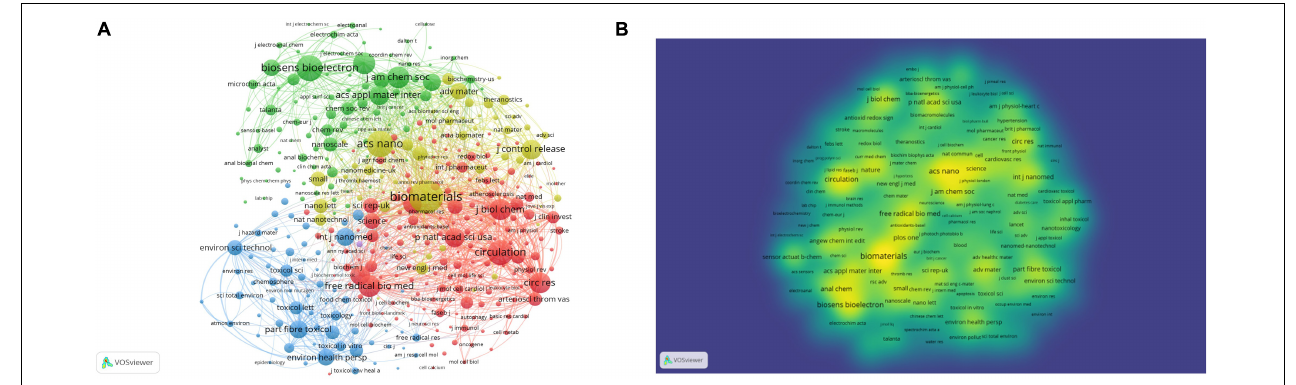
FIGURE 7 | Co-citation analysis of citated sources. Node size suggests the citation amount. Settings in VOSviewer Analysis:Minimum number of citations of a source: 20 (of the 4,772 sources, 378 meet the threshold) Method: Association strength; Layout: Attractions 6, Repulsion − 1. Clustering: Resolution 1.00, Min.cluster.size 1. (A) Network mapping of citated sources (four clusters). (B) Density mapping according to the citation amount of a source (yellow means more of a